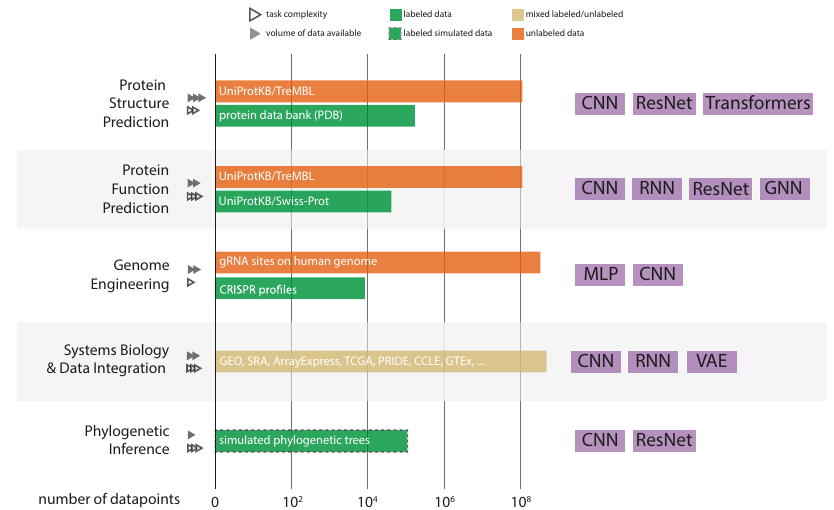
Fig. 2 A summary view of the major labeled and unlabeled datasets, and the architectures being used in deep-learning methods in computational biology. For each of the areas considered in this manuscript, it summarizes estimated sizes of key datasets and databases, as well as the projected growth rate of these. Additionally the rightmost column summarizes the most popular DL architectures applied to the corresponding areas in biosciences.